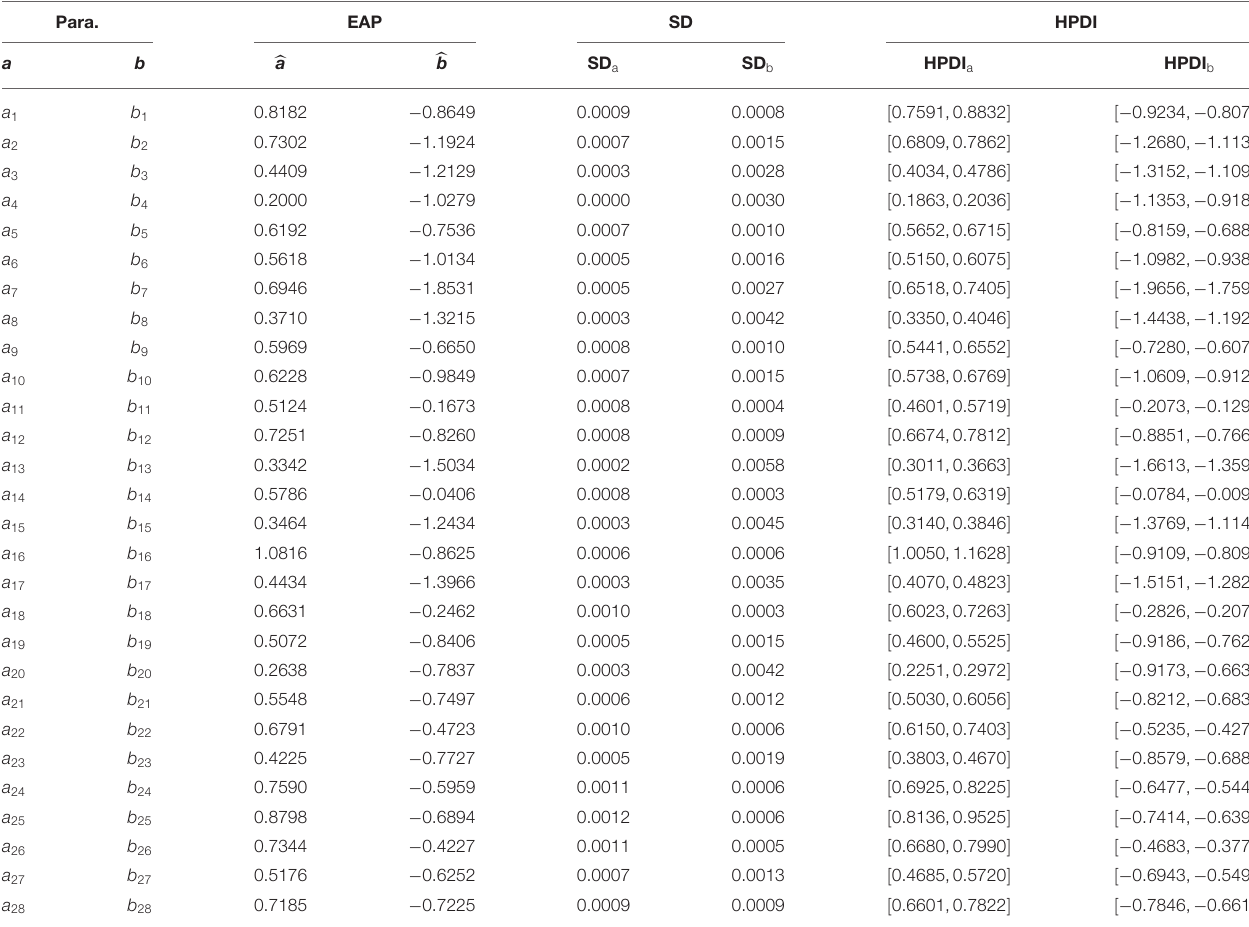
TABLE 5 | The estimation results of discrimination and difficulty parameter for the real data.